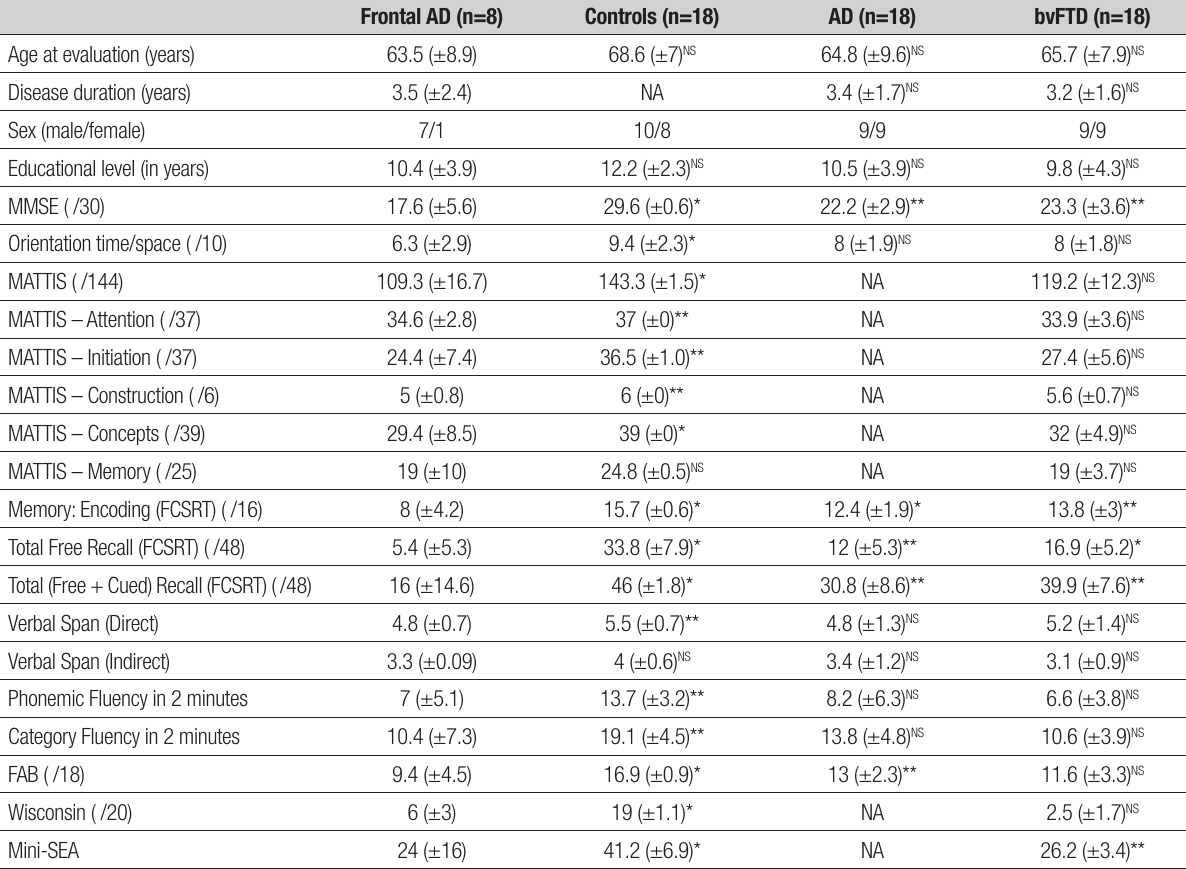
Table 3. Clinical and neuropsychological data between